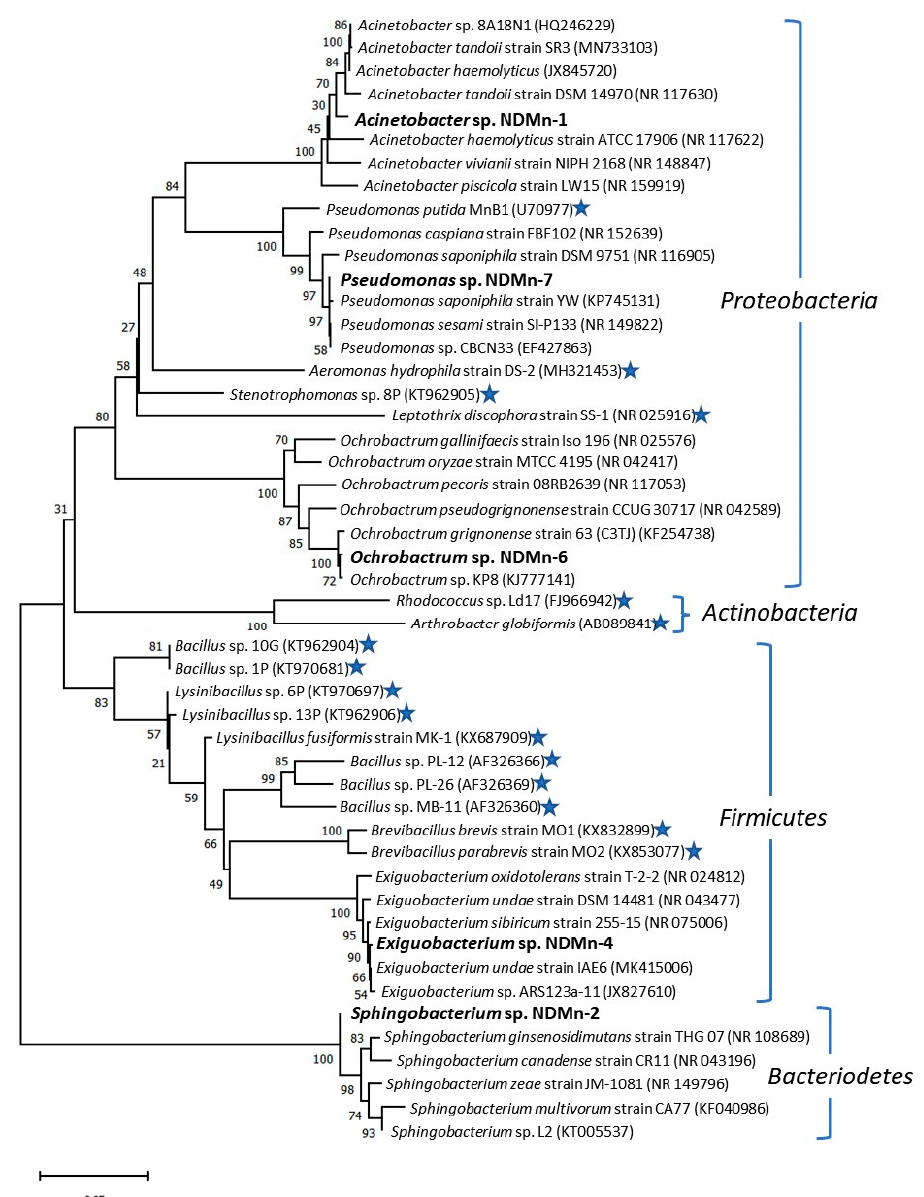
Figure 6. Phylogenetic tree showing the relationships of isolated bacteria with the closest relatives and previously reported Mn(II)-oxidizing bacterial strains. Bacterial strains in bold are isolated in this study. Bacterial strains with star mark are previously reported Mn(II)-oxidizing bacteria.